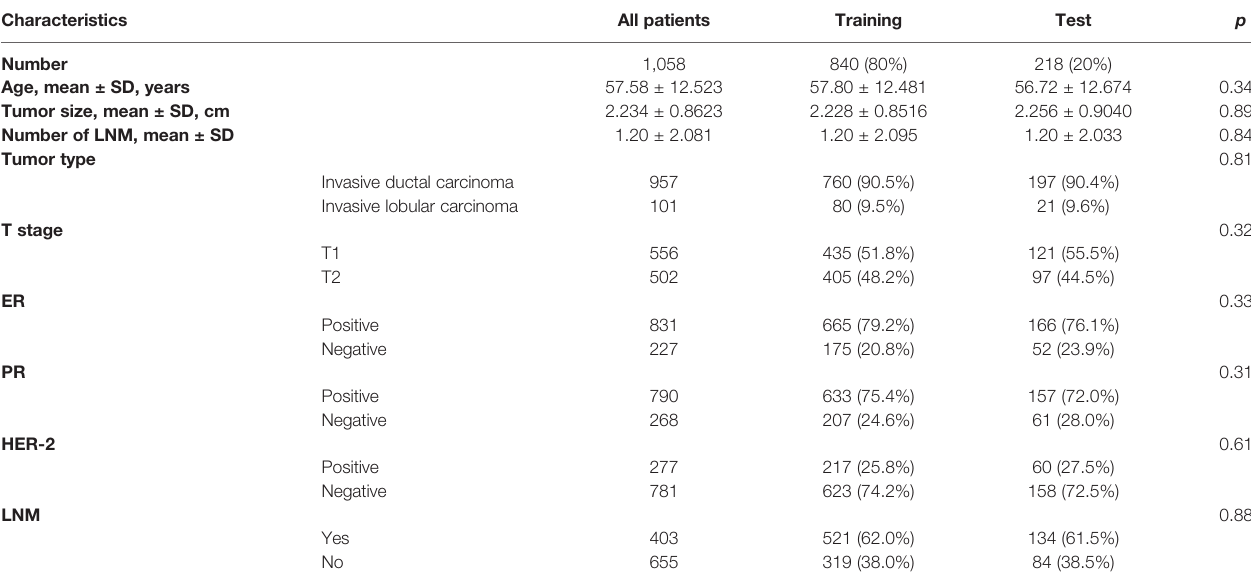
TABLE 1 | Patient and tumor